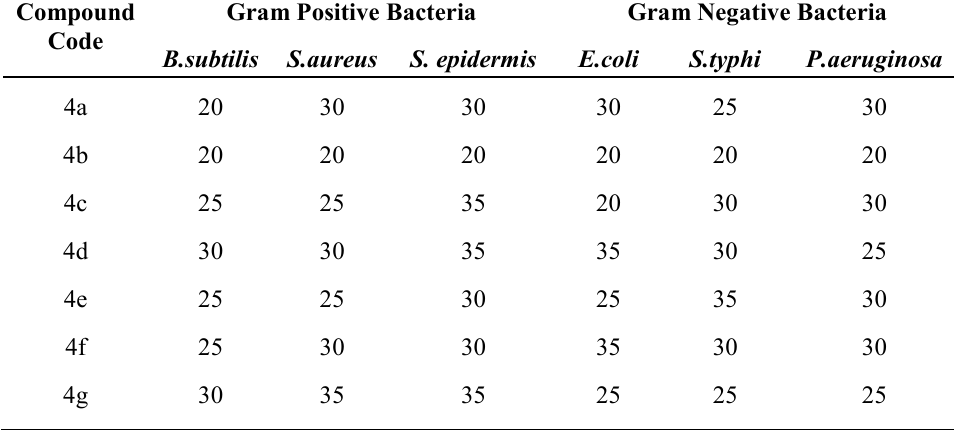
Table V: Minimum inhibitory concentration for the synthesized compounds (μg/ml). Compound